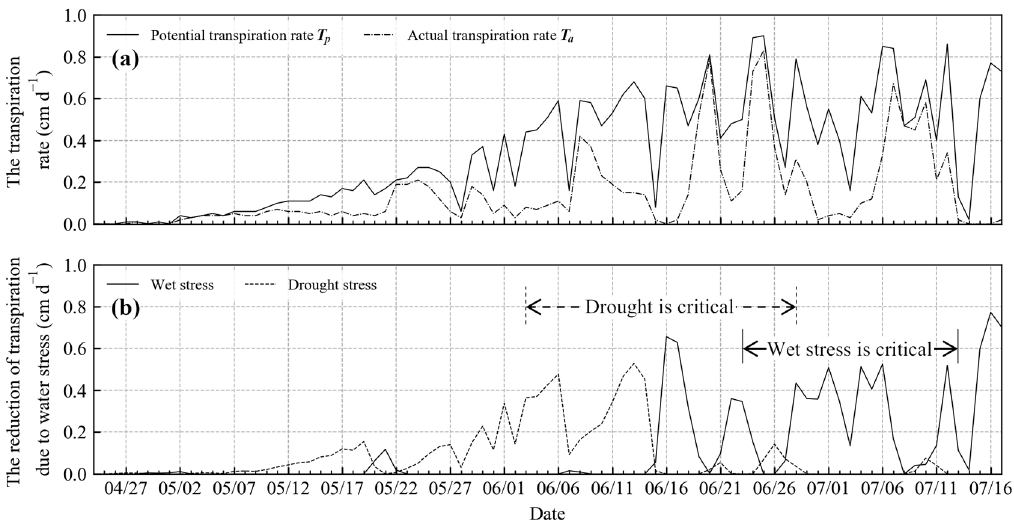
Figure 8. Potential and actual transpiration rates and water stress under actual conditions in 2019. ( a ) Transpiration rates; ( b ) water stress. The critical growth periods for drought and wet stresses were defined based on Çakir [3] and Kanwar et al. [4].